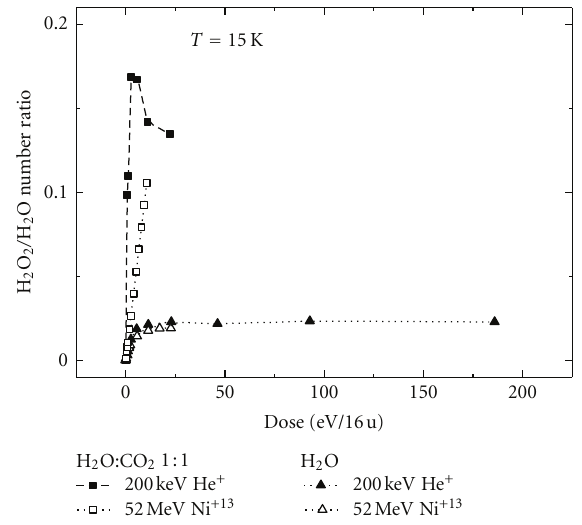
Figure 4: The column density ratios H 2 O 2 / H 2 O obtained after irradiation of pure water ice and a mixture H 2 O:CO 2 = 1:1 are reported versus the dose deposited by two di ff erent ions having di ff erent